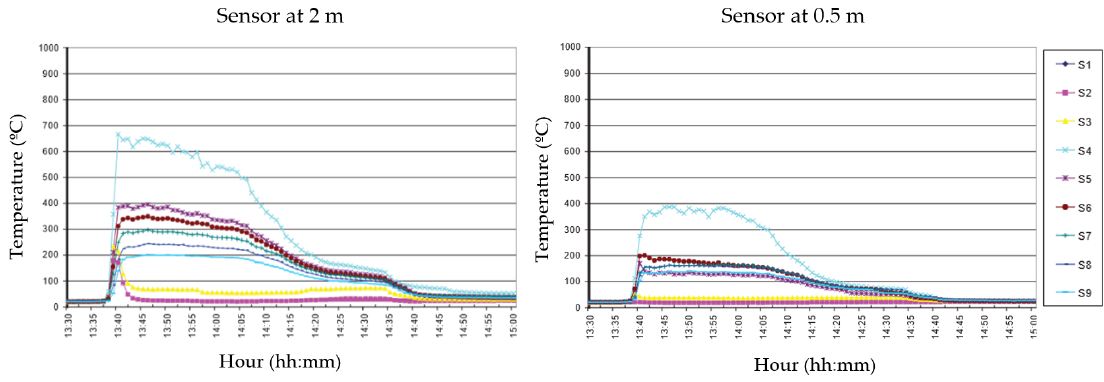
Figure 14. Evolution of the temperature along the drift at different heights; scenario 5.